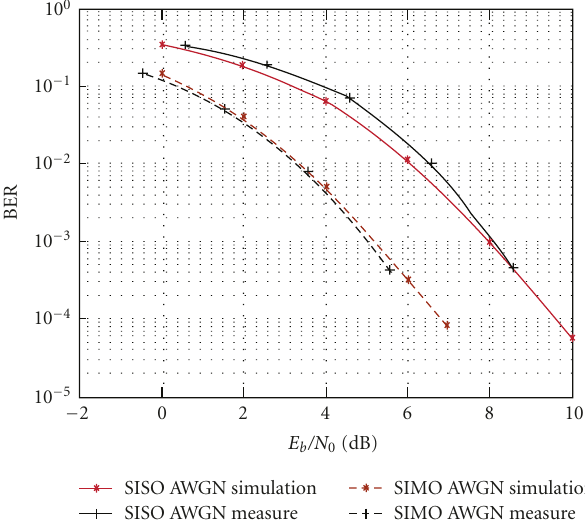
Figure 13: BER versus E b / N o for an 802.11g transmission with two received antennas in di ff erent channels. Table 2: Obtained BER with measured channels depending on channel spacing and antenna configuration.